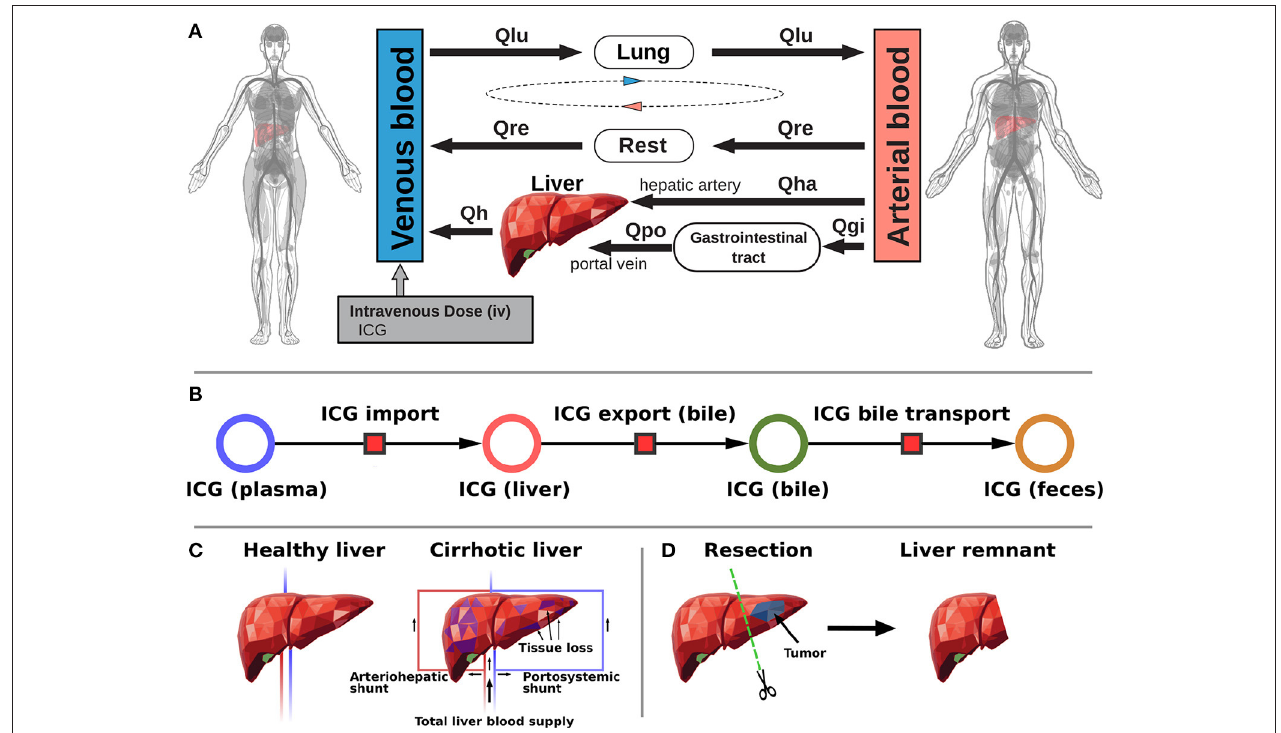
FIGURE 1 | Model overview. (A) Whole-body model. The whole-body PBPK model for ICG consists of venous blood, arterial blood, lung, liver, gastrointestinal tract, and rest compartment (accounting for organs not modeled in detail) and the systemic blood circulation connecting these compartments. (B) Liver model. ICG in the liver plasma compartment is taken up into the liver tissue (hepatocytes). Subsequently hepatic ICG is excreted in the bile from where it is excreted in the feces. No metabolization of ICG takes place in the liver. (C) Modeling liver cirrhosis. Liver cirrhosis was modeled as a combination of tissue loss and hepatic shunts (see main text for details). (D) Modeling hepatectomy. Hepatectomy was modeled as a removal of tissue volume with corresponding vessels (see main text for